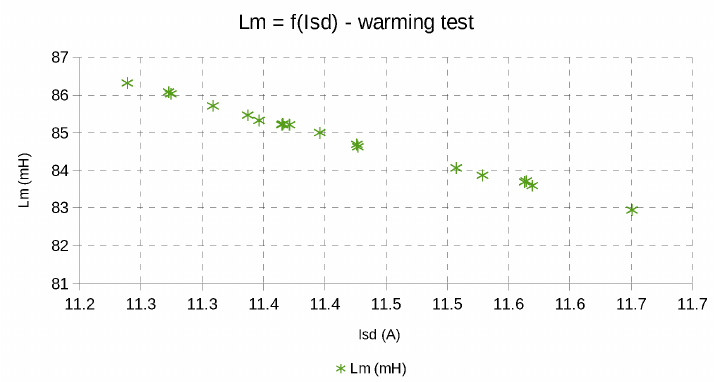
Figure 8. L m as a function of stator current component I sd during warming test.